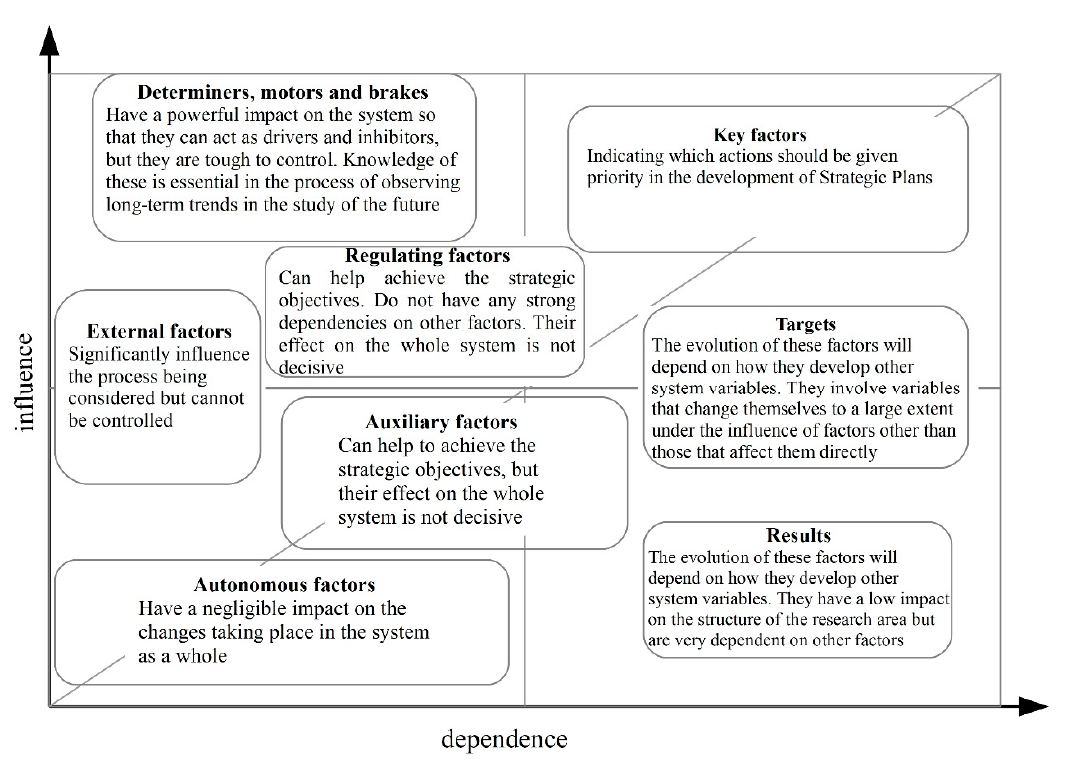
Figure 1. Definition of the location of important factors in the dependence-influence surface, based on the method descrip- tion.